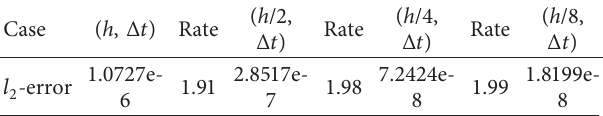
Table 2: Convergence test results of the fully implicit method for space step.